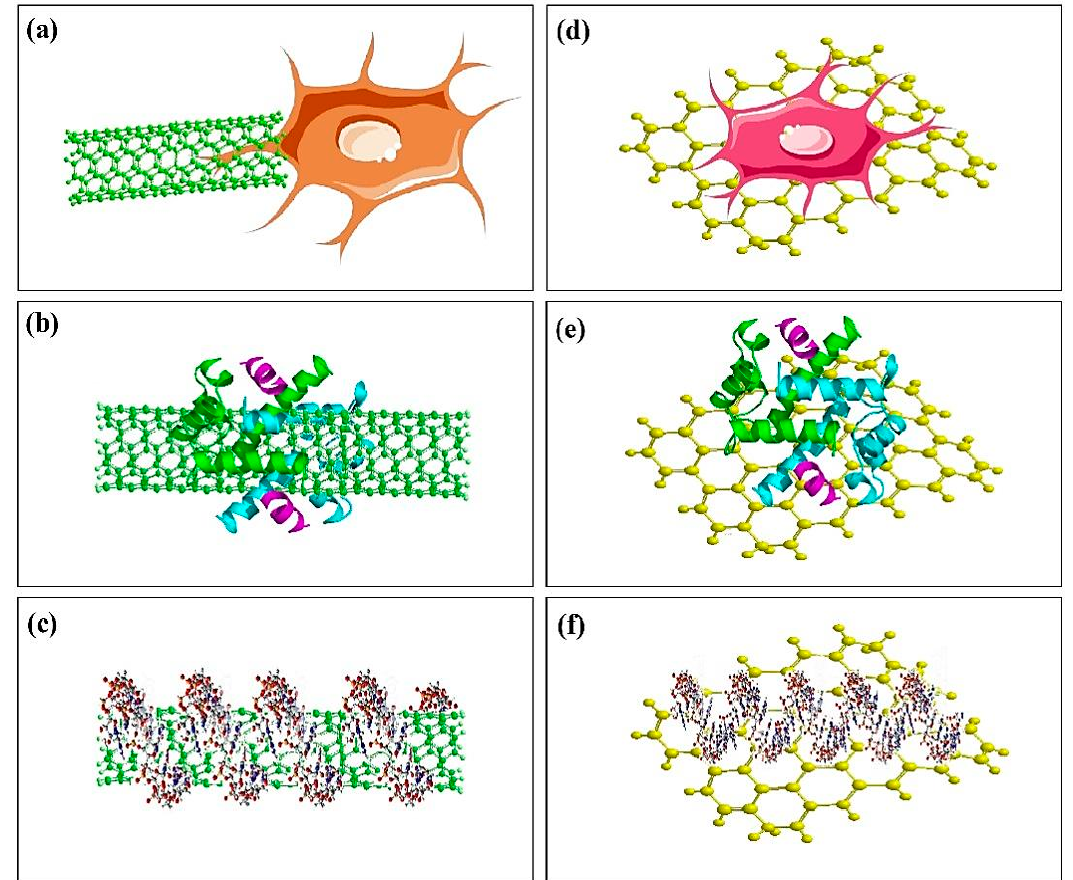
Figure 6. Schematic figure of interactions of CNTs and graphene with biological systems: ( a ) interaction of CNTs with cell, ( b ) adsorption of protein biomolecules on CNTs, ( c ) interaction of nucleic acids with CNTs, ( d ) interaction of graphene with cell, ( e ) adsorption of protein on graphene, and ( f ) interaction of nucleic acid with graphene [106]. Table 3. Cellular responses of the PMMA-based BCs containing MWCNTs, CS/MWCNTs, HA/GO,